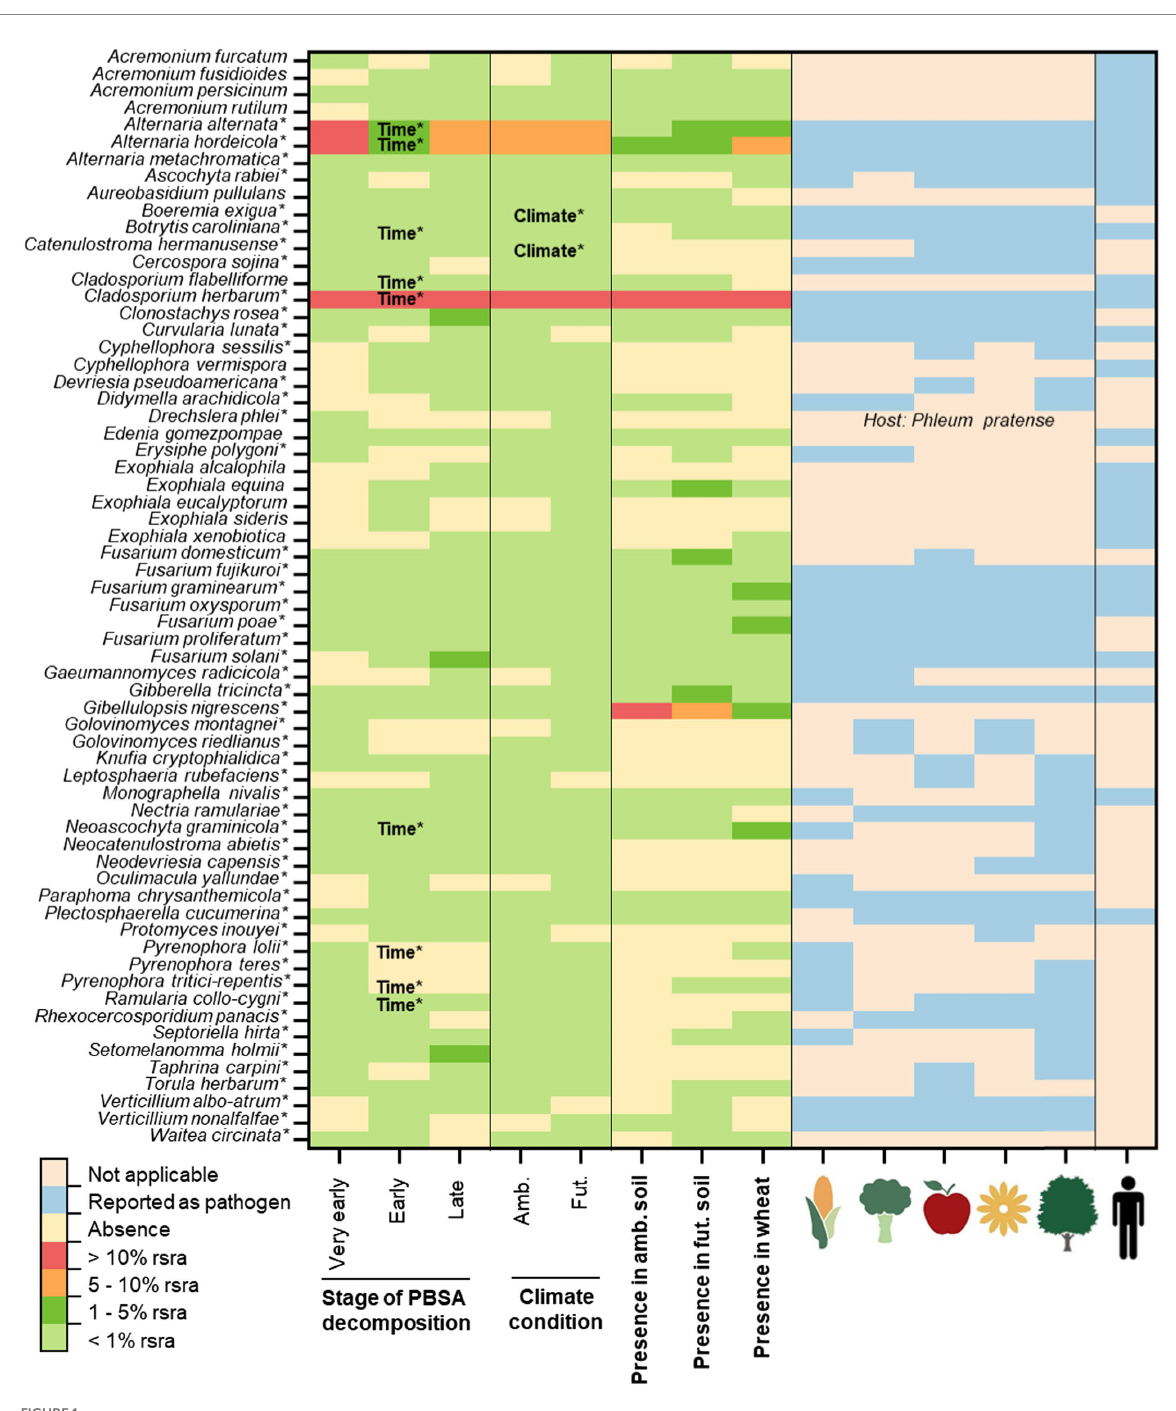
FIGURE 1 The occurrence of potentially pathogenic fungi detected in decomposing PBSA films (at very early, early and late stages of decomposition) in soils of ambient (amb.) and future putative (fut.) climate conditions using next generation sequencing (NGS). Their presence in early decomposing wheat straw is also shown. Pathogens are separated as plant pathogens [including, pathogens of different plant functional groups: cereal crops (corn symbol), vegetables (vegetable symbol), fruits (apple symbol), ornamental plants (flower symbol) and trees (tree symbol); the host plants are associated with the UNITE Species Hypothesis (SH) of each plant pathogen identified according to database of UNITE (Nilsson et al., 2019)] and opportunistic human pathogens (human symbol; Supplementary Table S1). The symbol (*) indicates the confirmation of status “plant pathogen” accoding to relevant references (Supplementary Table S1). Time* and climate* indicate significant effects accoding to repeated measure ANOVA ( p < 0.05) (Supplementary Table S6). The abbreviation “rsra” refers to relative sequence read